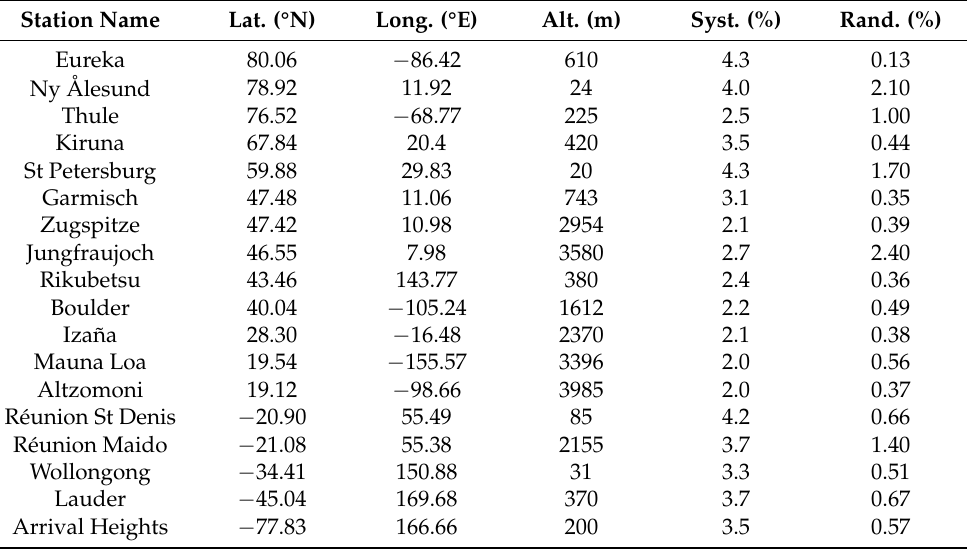
Table 2. List of NDACC stations used in this work, with the reported mean N 2 O systematic and random uncertainties.